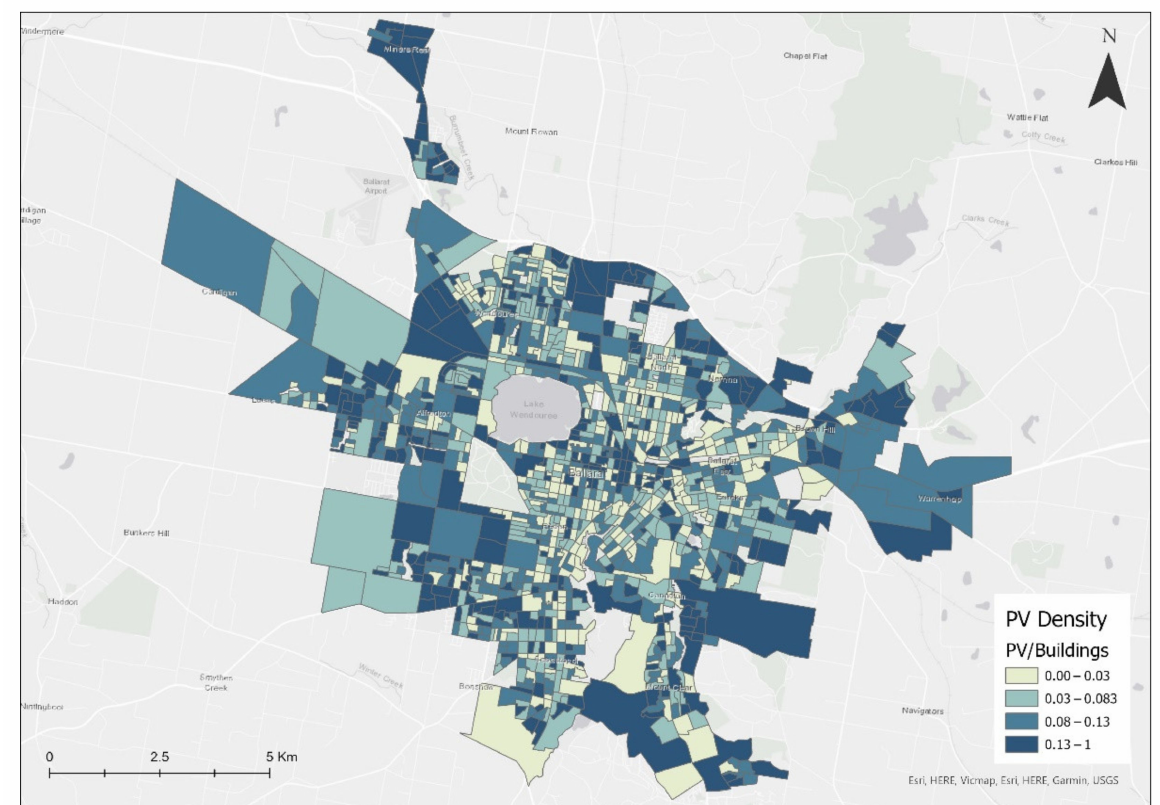
Figure 7. Spatial distribution of the detected solar panels at the SA1